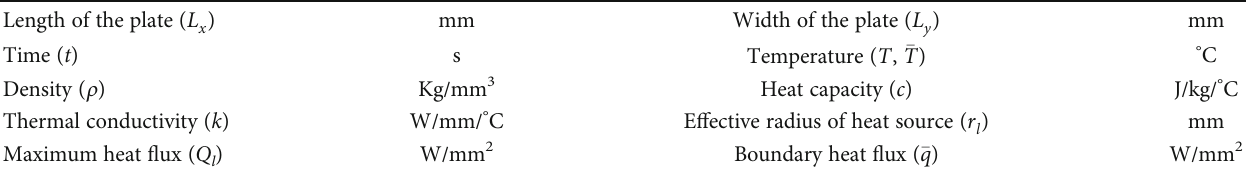
Table 1: Units of parameters for numerical